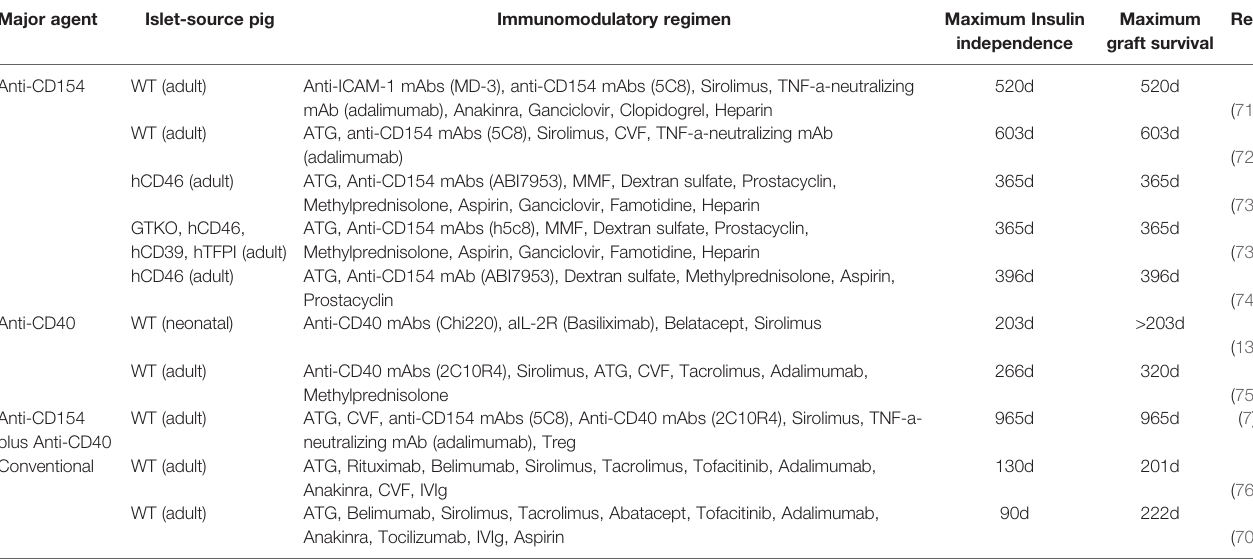
TABLE 5 | Immunosuppressive protocols associated with prolonged periods of insulin-independence and islet graft